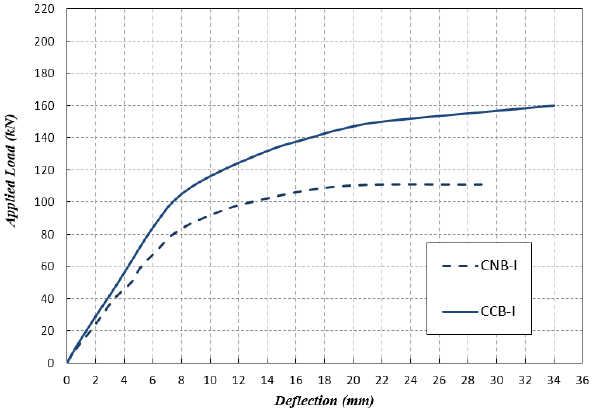
Figure 12: Load-deflection curves of Specimens CNB-I and CCB-I